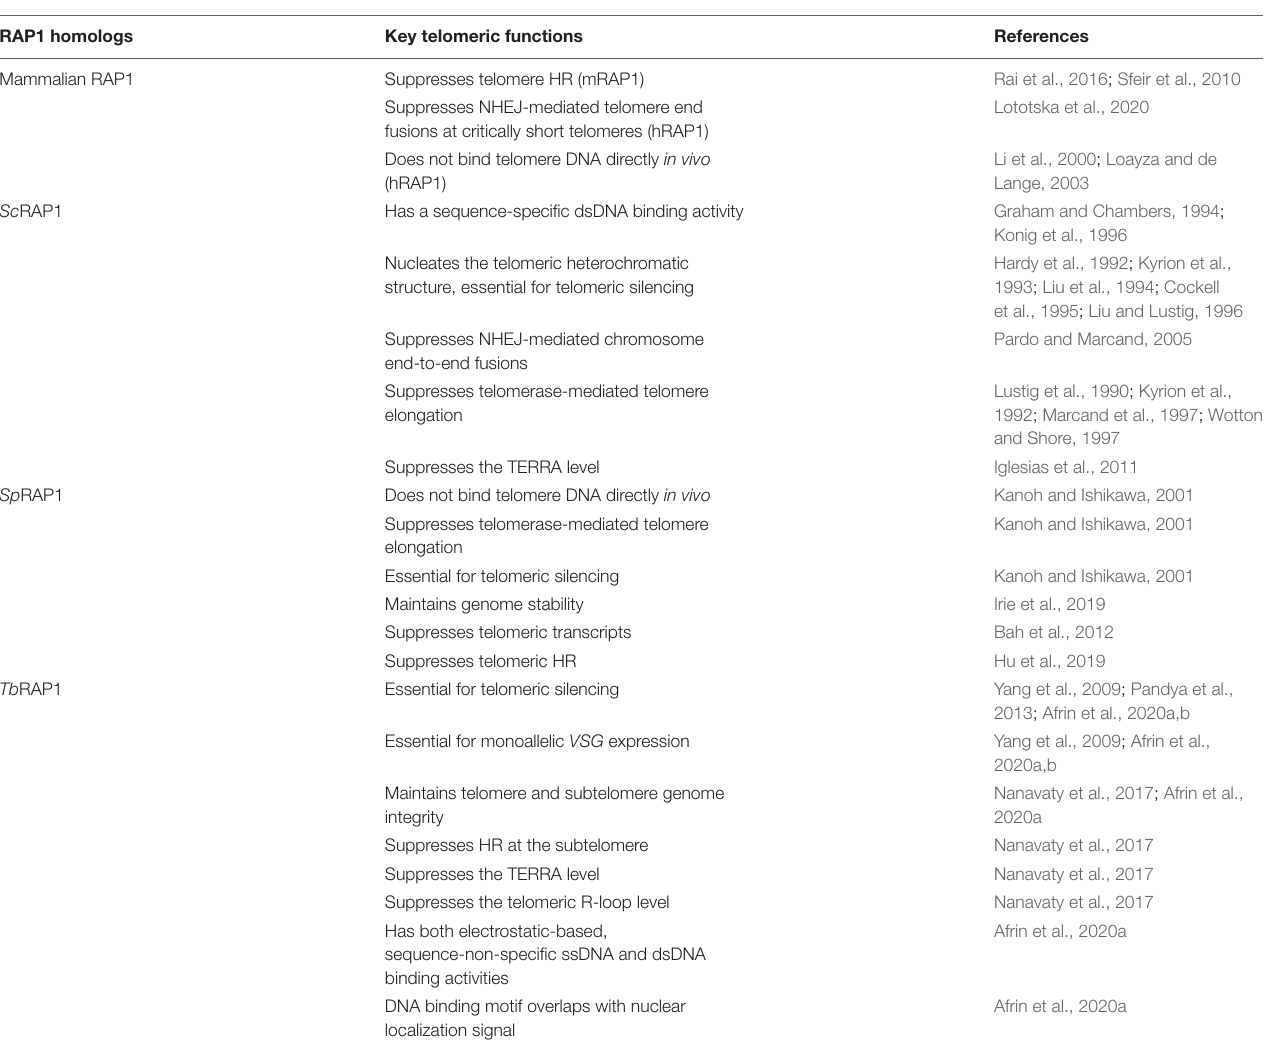
TABLE 2 | Summary of key telomeric functions of RAP1